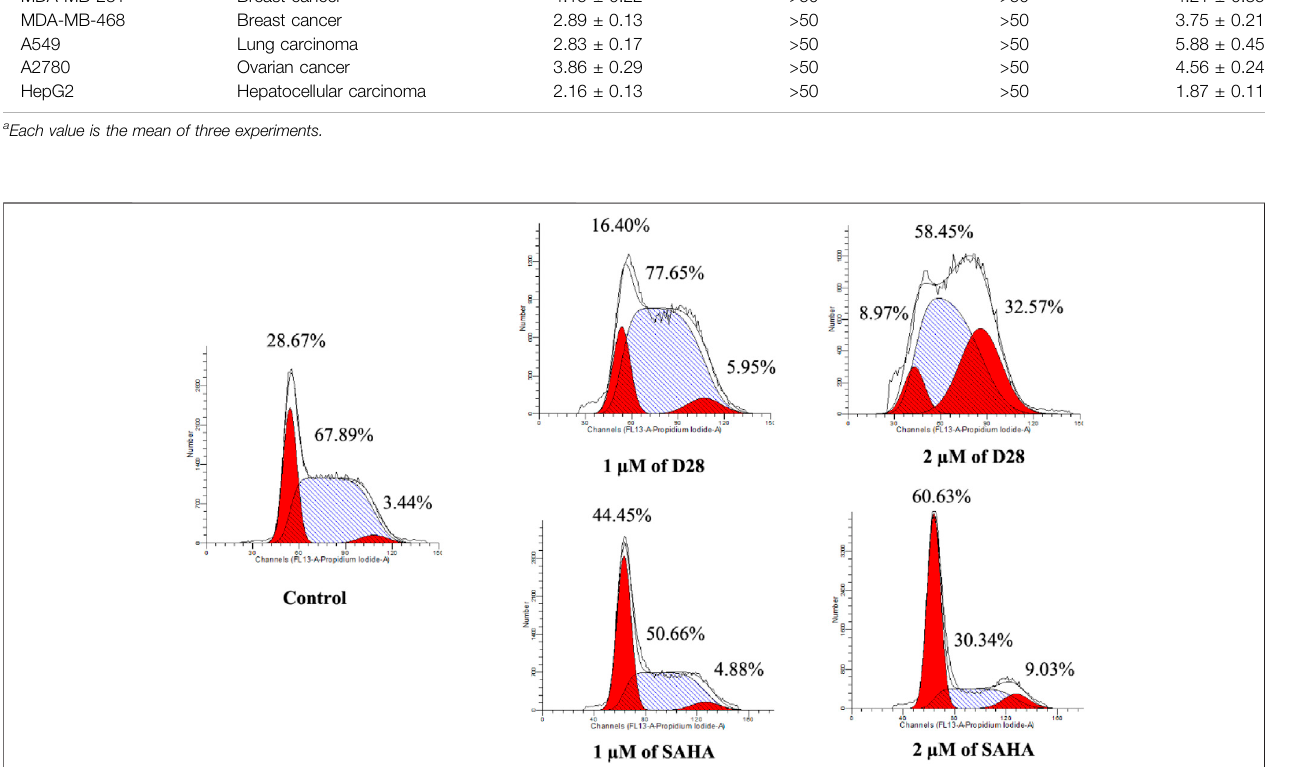
Frontiers in Chemistry |